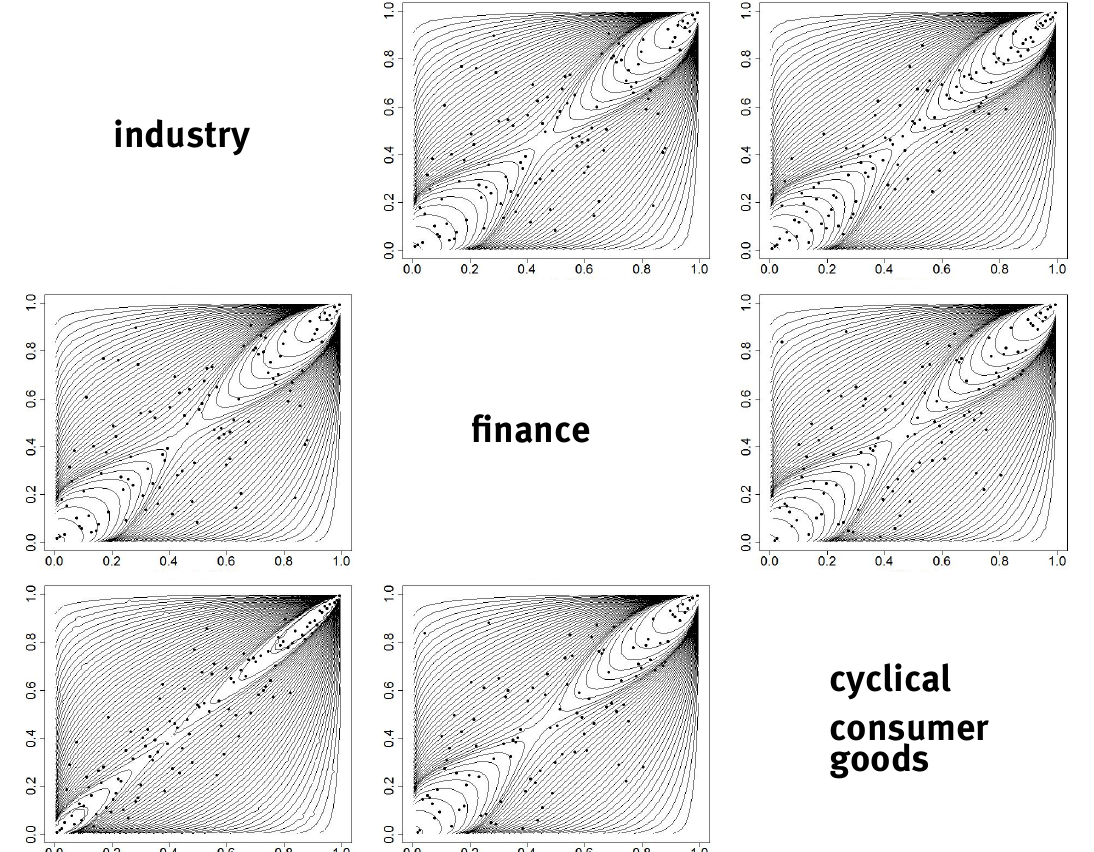
Fig. 6. Estimated bivariate (hierarchical) Archimedean Gumbel copulas (upper triangle matrix: ordinary Gumbel copula, lower triangle matrix: hierarchical Archimedean Gumbel